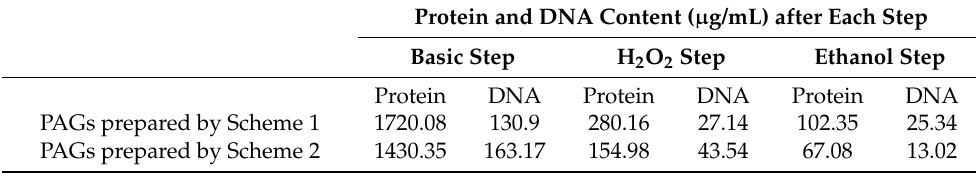
Table 2. Protein and DNA content of prepared PAGs.